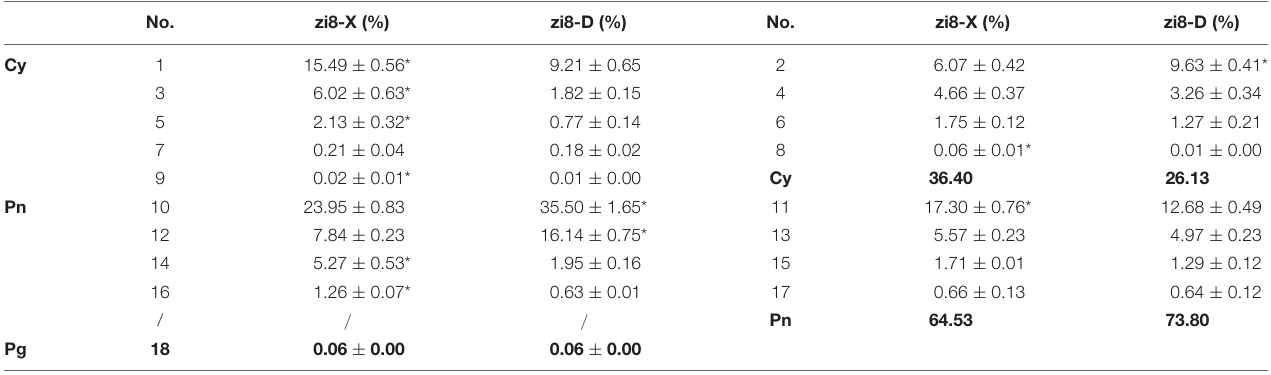
TABLE 2 | The identification and quantification of Cy, Pn,and Pg from zi8-X and zi8-D.